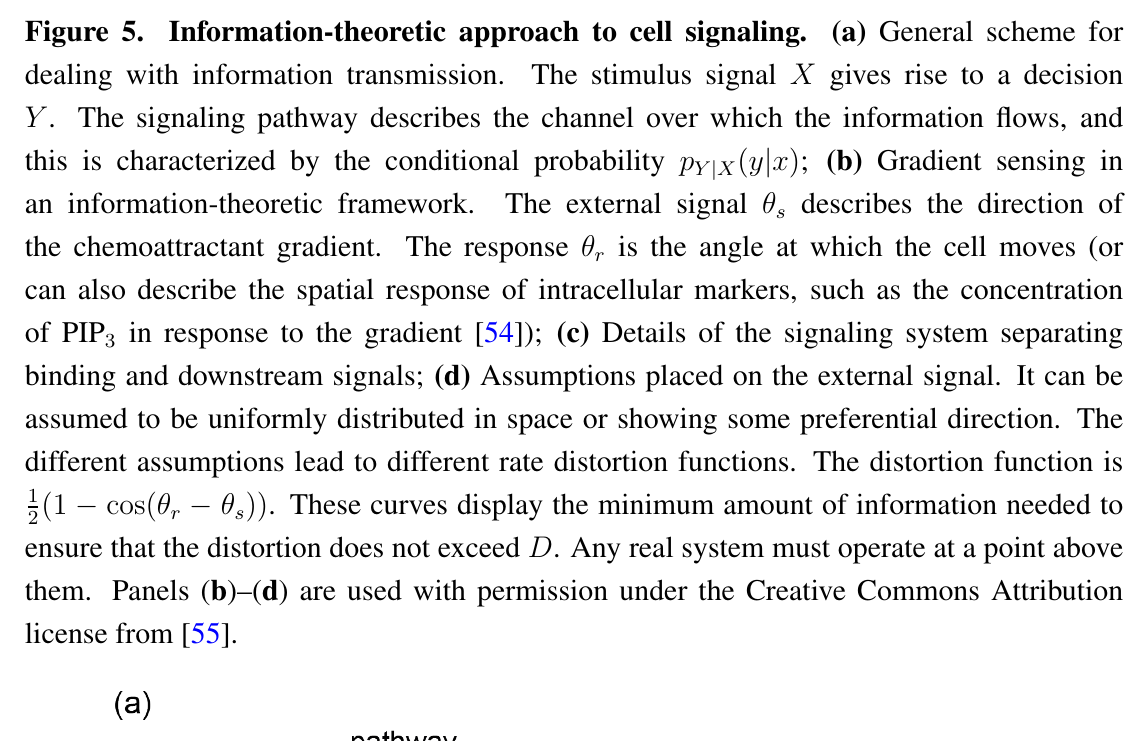
Figure 5. Information-theoretic approach to cell signaling. (a) General scheme for dealing with information